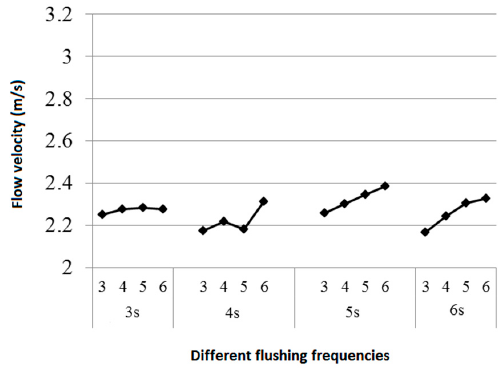
Figure 8. Comparison of water flow velocity at all frequencies (round nozzle on top of the pipe).